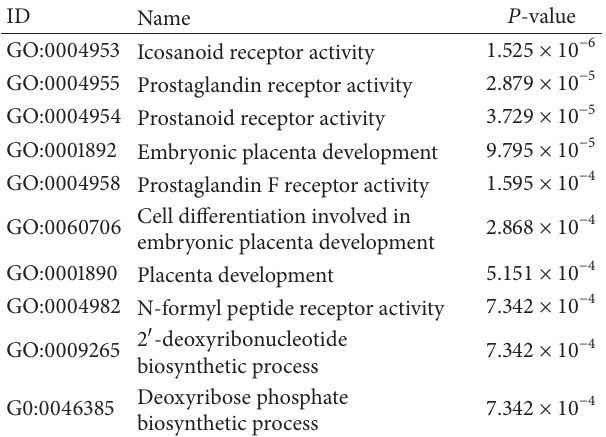
Table 8: GO analysis for tricluster TC 20 in Mouse GDS4510